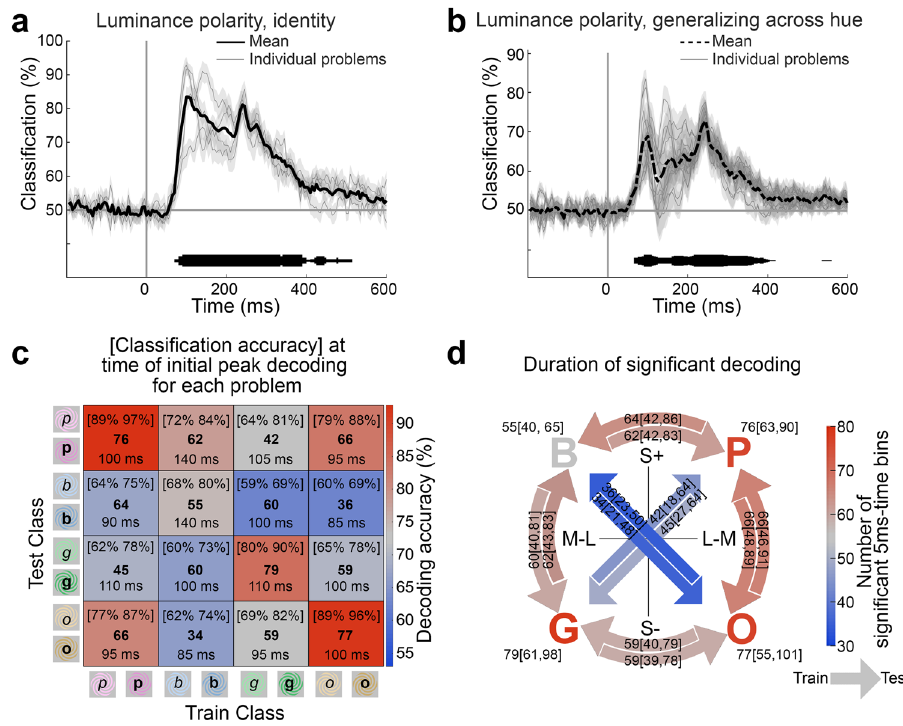
Fig. 7 Decoding luminance polarity carried by different hues. a Accuracy of classi fi ers trained to decode luminance polarity on the identity problems (individual problems, thin lines; average, thick line). b Accuracy of classi fi ers trained to decode luminance polarity across hues (12 generalizing-across-hue problems, thin lines; average, thick dashed line; shading shows SE across subjects). The thickness of the horizontal line above the x -axis shows the number of decoding problems (maximum in a, 4; maximum in b, 12) that were signi fi cant in each 5 ms bin (cluster corrected). c Heatmap showing classi fi er performance [95% CI, by bootstrapping] for each binary classi fi er at the initial peak decoding for each problem. Bold numbers show the total number of 5 ms time bins with signi fi cant classi fi cation performance. The time stamps show when the classi fi er performance reached the initial peak in decoding accuracy. d Duration of signi fi cant decoding of luminance polarity plotted in the cone-opponent color space used to de fi ne the stimuli; B, P, O, and G demarcate within this space the location of the blue, pink, orange, and green hues of the stimuli. The color scalebar indicates the number of 5 ms time bins that were signi fi cant, and the arrow direction points from the hues used for training to the hues used for testing. For example, the arrow from P to G corresponds to classi fi ers trained on luminance polarity using data obtained with light/dark pink stimuli and tested using data obtained with light/dark green stimuli. For the four identity problems (the letters B, P, O, and G), the hue was the same for training and testing. For each type of problem, the precise number of signi fi cant time bins is shown, along with the [95% CI] obtained by bootstrapping. Problems that cross the color space, in which the hues for training and testing varied in both L-M and S activation, showed lower numbers of signi fi cant time bins than problems around the perimeter of the color space, in which the hues for training and testing varied in only L-M or